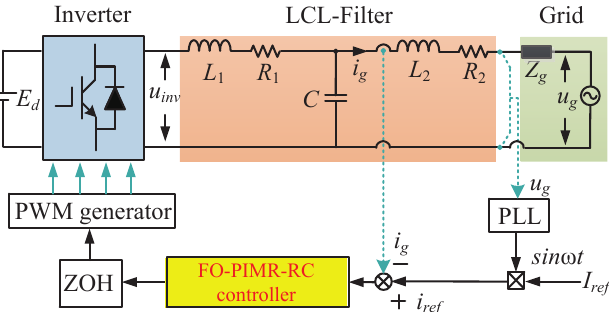
Figure 3. Single-phase LCL-type grid-tied inverter structure with FO-PIMR-RC